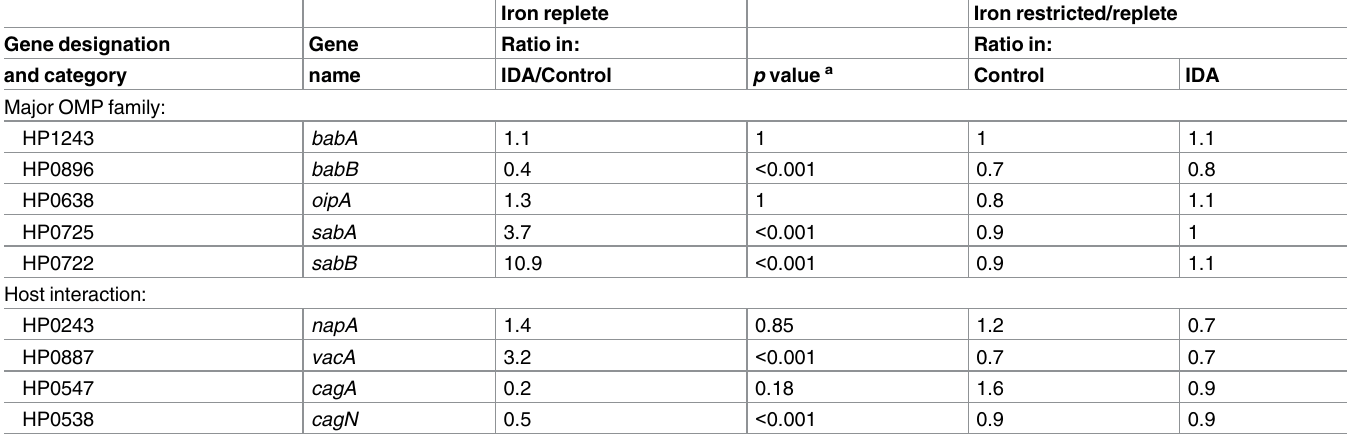
Table 5. Expression of H . pylori OMPs and genes associated with host